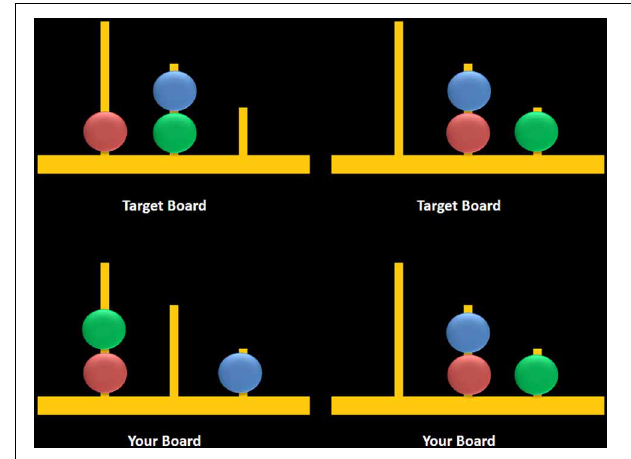
FIGURE 3 | Sample computerized stimuli from the Scarborough adaptation of the Tower of London task. The left panel displays sample problems requiring a minimum of two moves to solve the problem (left) or zero moves to solve the problem (right). Stimuli were designed based on descriptions provided in Shallice